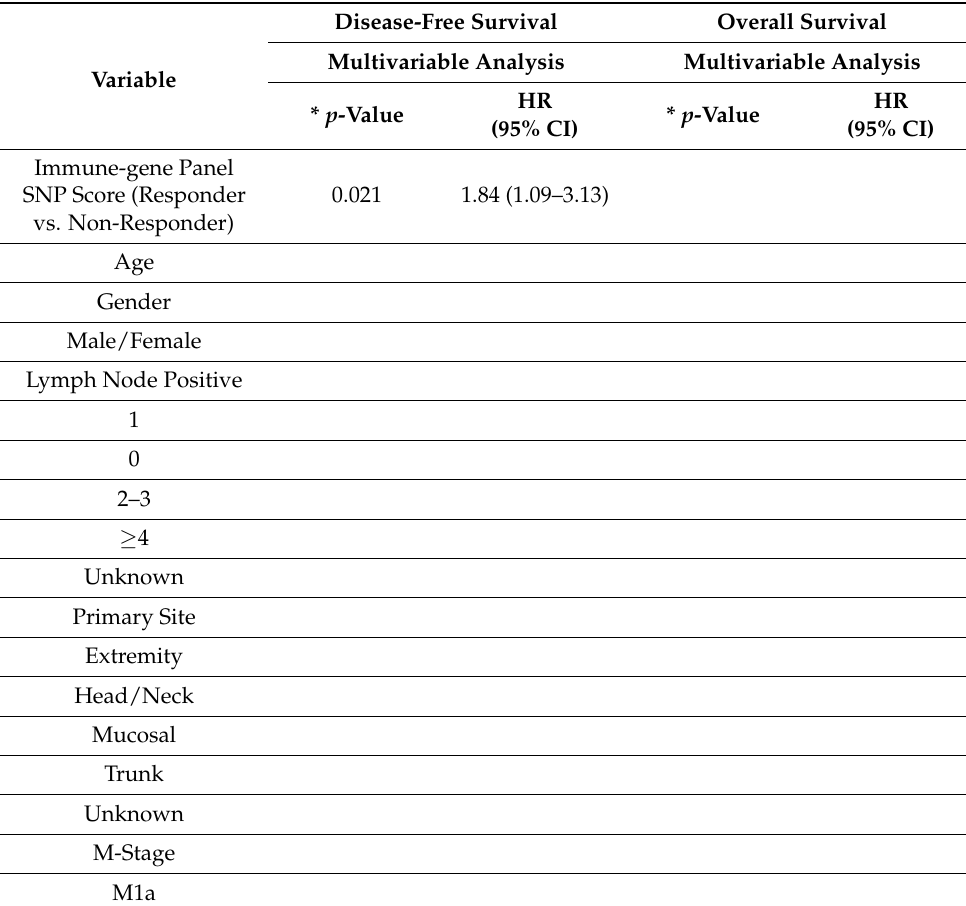
Table 2. Multivariable stepwise Cox regression analysis of disease outcome: biomarker SNP panel and clinicopathologic characteristics in the discovery cohort of MMAIT stage IV BCG-treated